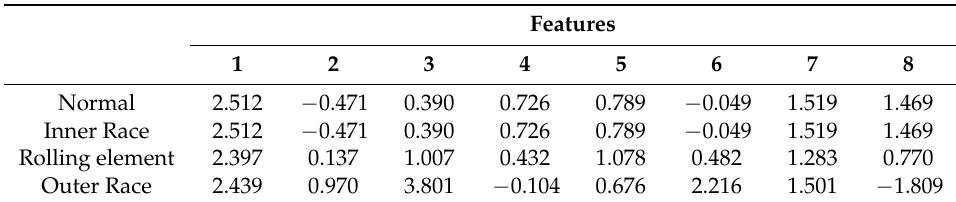
Table 6. The signal-to-noise ratio ( SNR) gain of features.